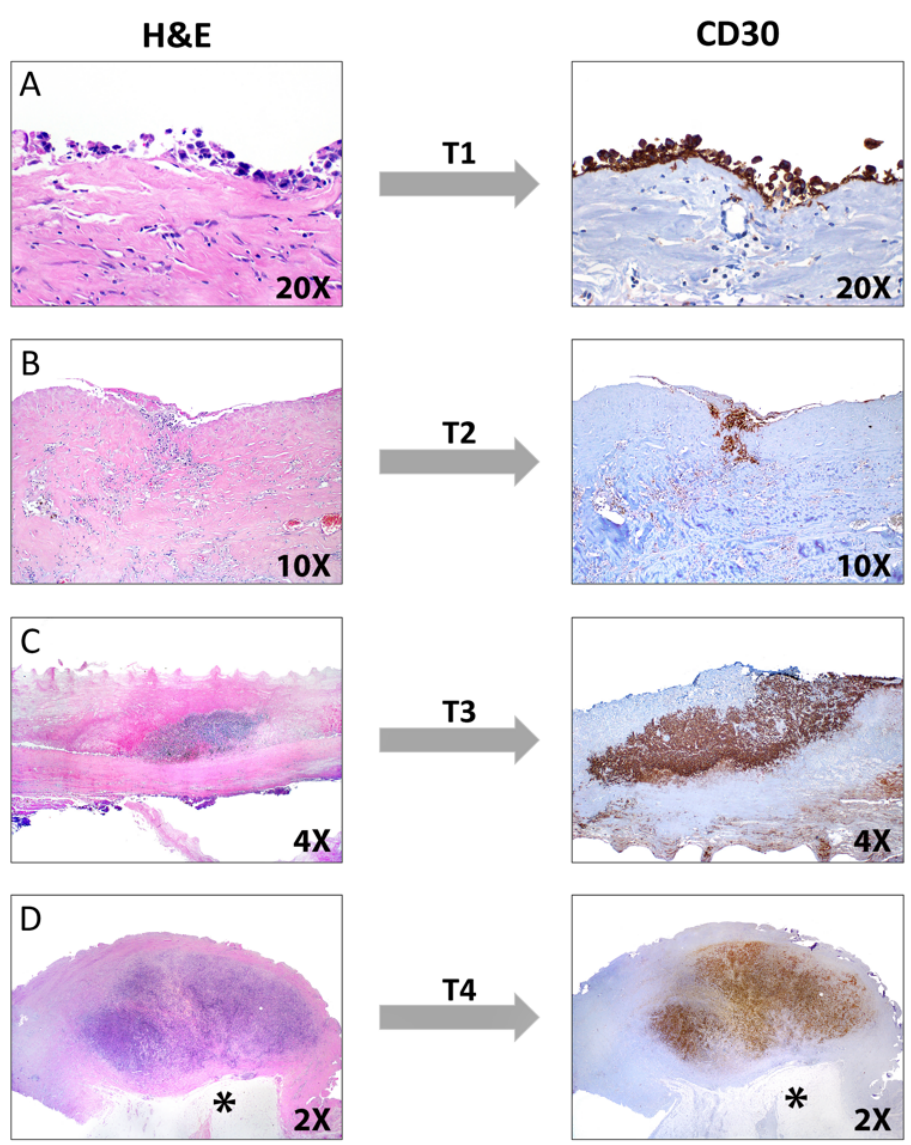
Figure 18. Pathologic tumor stage (T) used in breast implant-associated ALCL. Left panel: hematoxylin and eosin stain, H&E. Right panel: CD30 immunostain. ( A ) T1, the lymphoma cells are present only in the effusion and/or confined to the lumen of the fibrous capsule. ( B ) T2, sparse neoplastic cells infiltrate the capsule. ( C ) T3, solid aggregates or sheets of lymphoma cells within the capsule; ( D ) T4, a solid nodule of lymphoma cells occupies the entire capsule thickness and approaches the adipose tissue and breast parenchyma (asterisk). Immunohistochemistry for CD30 is more accurate to evaluate the level of infiltration of the